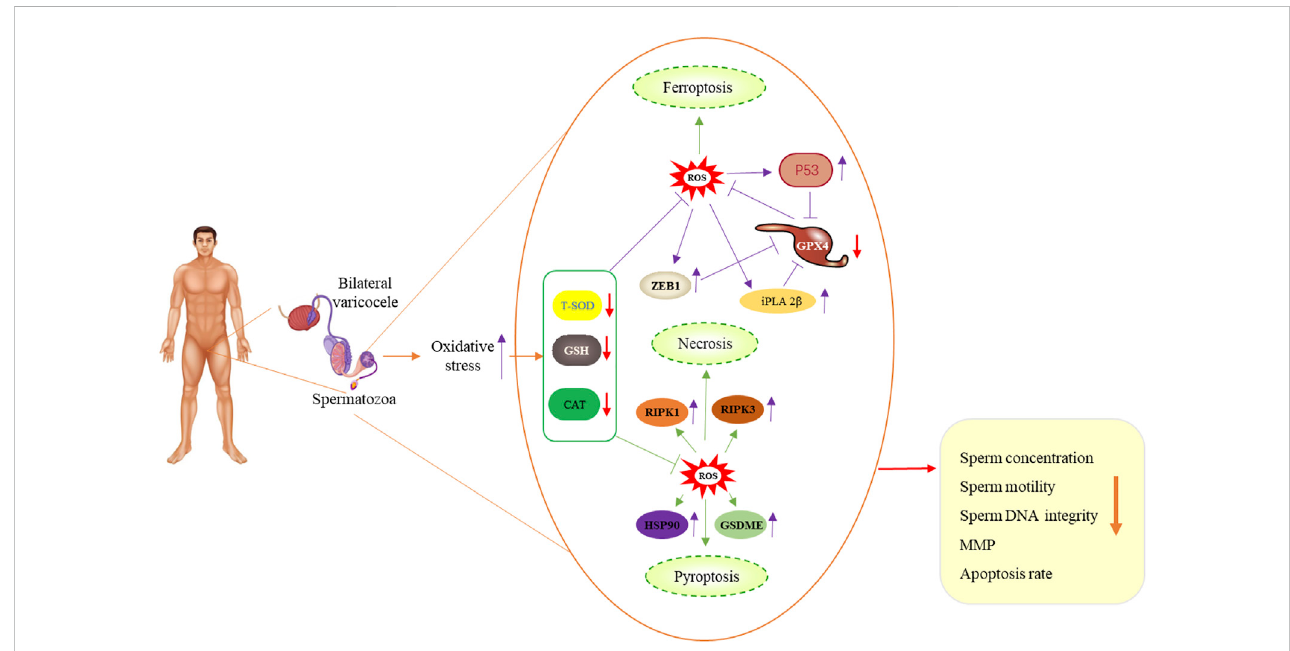
FIGURE 7 Schematic illustration of bilateral varicocele promoting ROS as well as ferroptosis, pyroptosis and necrosis in human